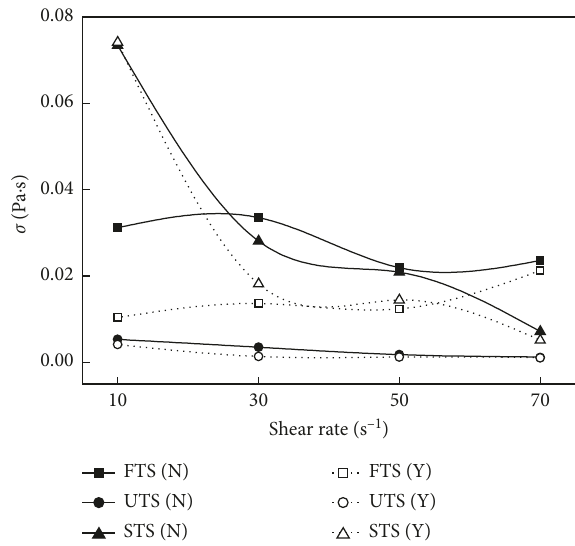
Figure 4: Varying tendency of Δ η with shear rate. Figure 5: Varying tendency of σ with shear rate (N means no JC b APAM addition; Y means with optimal APAM